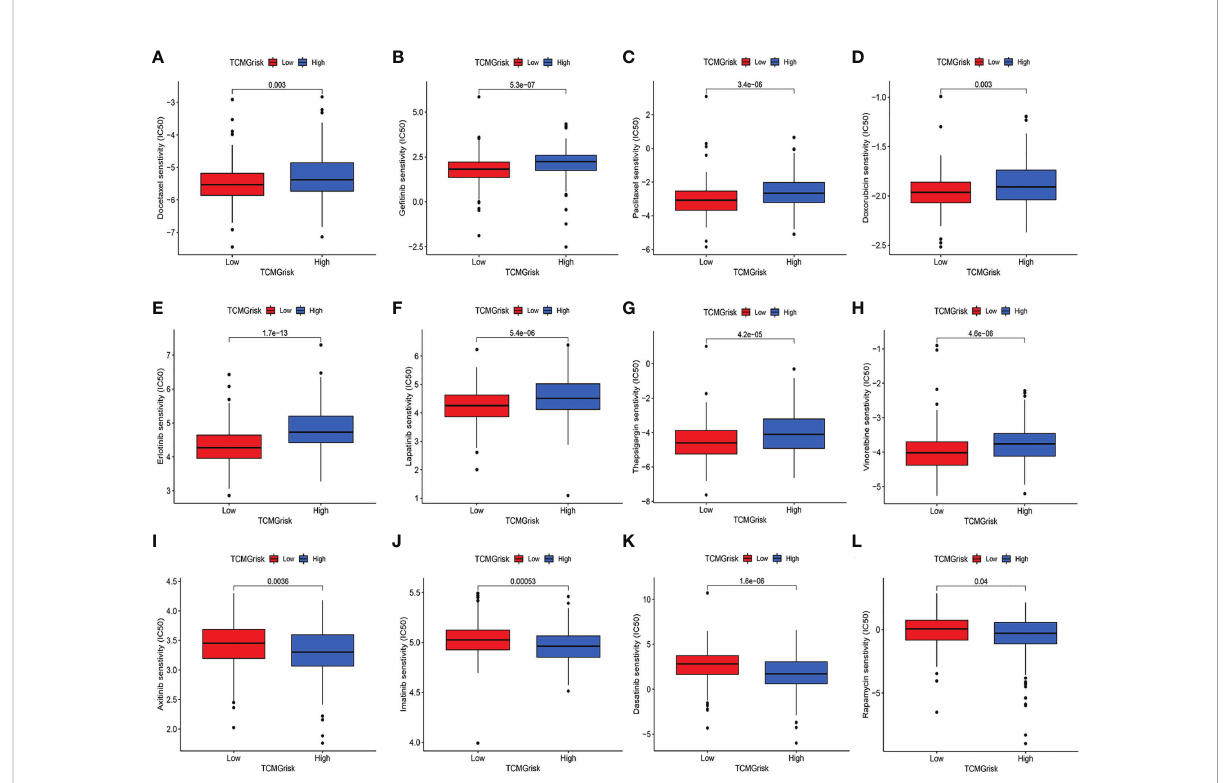
FIGURE 7 Evaluation of drug sensitivity. The comparisons in IC50 value of Docetaxel (A) , Ge fi tinib (B) , Paclitaxel (C) , Doxorubicin (D) , Erlotinib (E) , Lapatinib (F) , Thapsigargin (G) , Vinorelbine (H) , Axitinib (I) , Imatinib (J) , Dasatinib (K) , and Rapamycin (L) between low-risk and high-risk